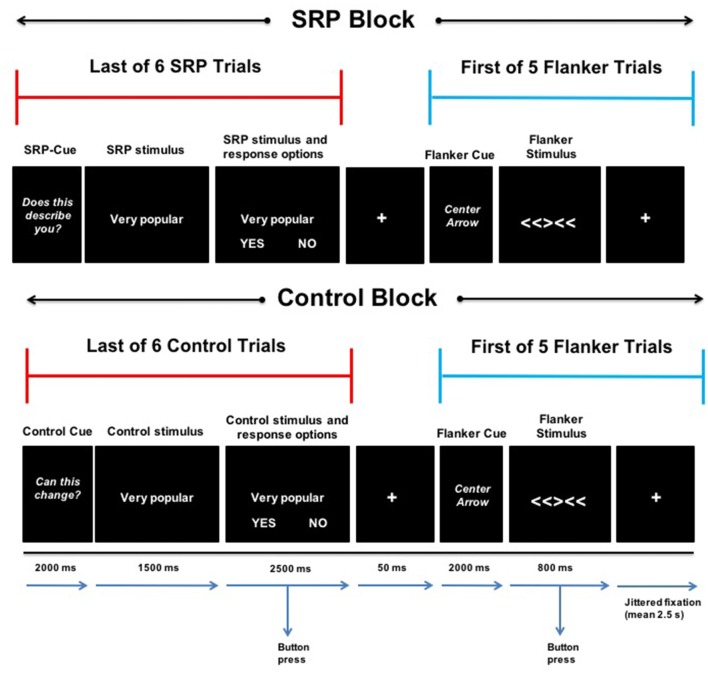
Self-referential processing (SRP)-Flanker Task. The last of six consecutive SRP (top) and Control (bottom) trials (separated by jittered fixation; mean 2.5 s) is presented next to the first of five consecutive Flanker trials (separated by jittered fixation; mean 2.5 s) during an SRP (top) and Control (bottom) block. SRP and Control blocks included a 2-s cue, followed by 4-s stimulus with the options “YES” and “NO” during the last 2.5 s. During SRP blocks, participants indicated with a button press whether the stimulus phrase described them (yes or no; top). In the case of Control trials, participants indicated whether the stimulus phrase can change in other people (yes or no; bottom). A 50-ms fixation separated the last SRP and Control trials from the first Flanker trial of SRP and Control blocks, respectively. Flanker trials began with a 2-s cue, followed by a 0.8-s stimulus presentation of an incongruent or congruent (not shown) condition, during which participants indicated the direction the center arrow was pointing (left or right).